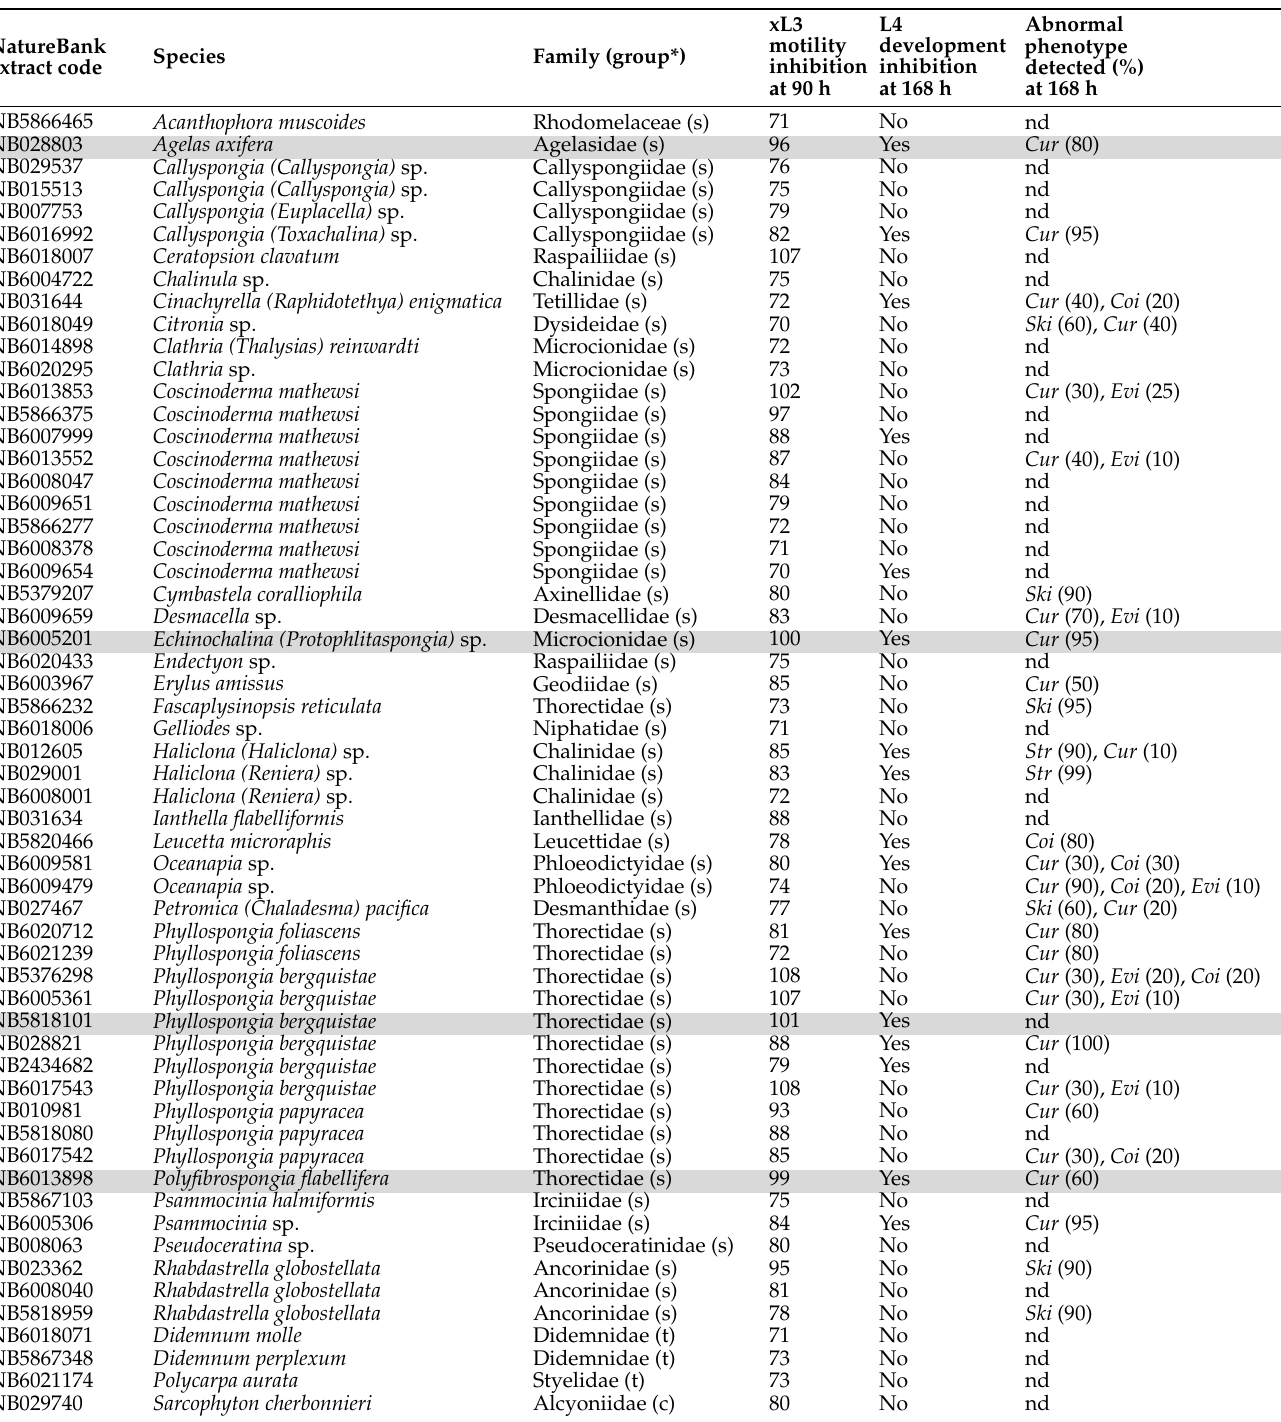
Table 1. The 58 ‘hit’ extracts identified in the primary screen with in vitro activity against exsheathed third-stage larvae (xL3s) of Haemonchus contortus . Information about the extracts, including code and source organism (species and family/group) used for screening, is listed. The results from the screen include xL3 motility inhibition (threshold: ≥ 70%) at 90 h; developmental inhibition (threshold: ≥ 80%) of fourth-stage larvae (L4) at 168 h; and the larval phenotypes observed at 168 h. Larval phenotypes observed were coiled ( Coi ), curved ( Cur ), eviscerated ( Evi ), skinny ( Ski ) or straight ( Str ) (Figure 2; cf. [20]). Shaded are extracts that inhibited larval motility by ≥ 90% (90 h) and development by ≥ 80% (168 h) in the